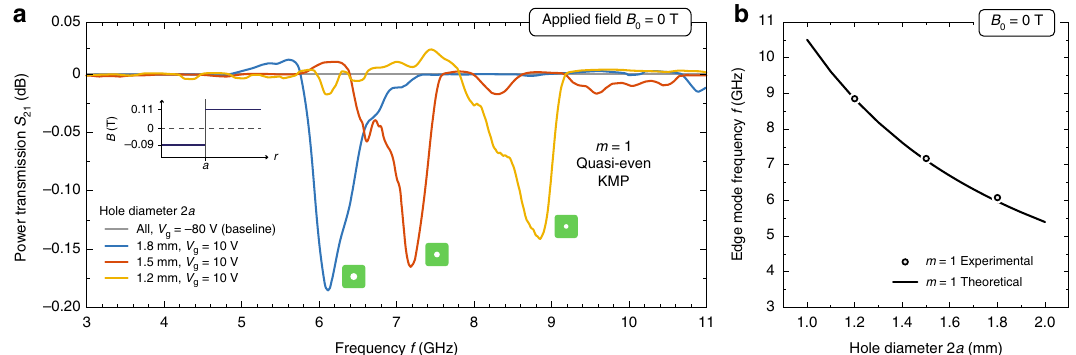
Fig. 9 Kink magnetoplasmons (KMPs) for distinct magnetic hole diameters. a Measured power transmission S 21 (normalized to indicated baselines) as a function of frequency for the fi xed applied magnetic fi eld B 0 ¼ 0T and gate voltage V between experimental observations and theoretical calculations, n 0 ¼ 2 : 64 ´ 10 11 cm (cid:3) 2 (at 10 V gate voltage)